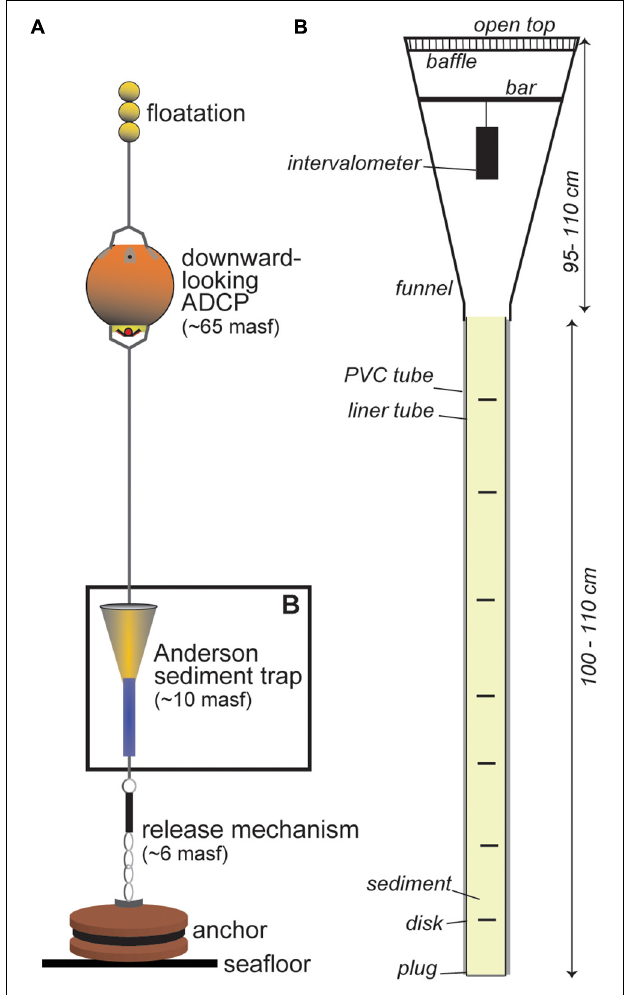
FIGURE 2 | Schematic illustrations of Coordinated Canyon Experiment moorings and sediment traps deployed in Monterey Canyon. (A) Anderson-type sediment trap on mooring (not to scale) (modified from Paull et al., 2018). ADCP: acoustic Doppler current profiler. masf, meters above the seafloor. (B) Anderson-type sediment trap (not to